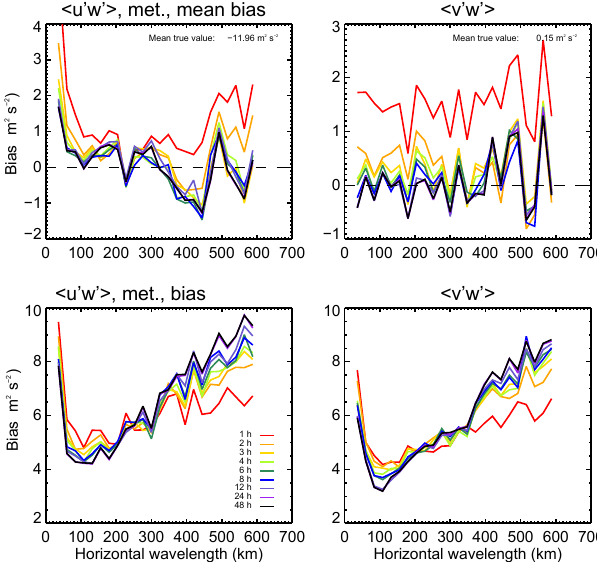
Figure 7. A comparison of the biases in the model momentum flux terms extracted from the 5BD technique for different integration times (1, 2, 3, 4, 6, 8, 12, 24, and 48h, with colours as shown in the key), for a spectrum of waves propagating in the eastern sector (Case 2). Average biases are shown in the upper panels, and the standard deviations of the biases in the lower panels.